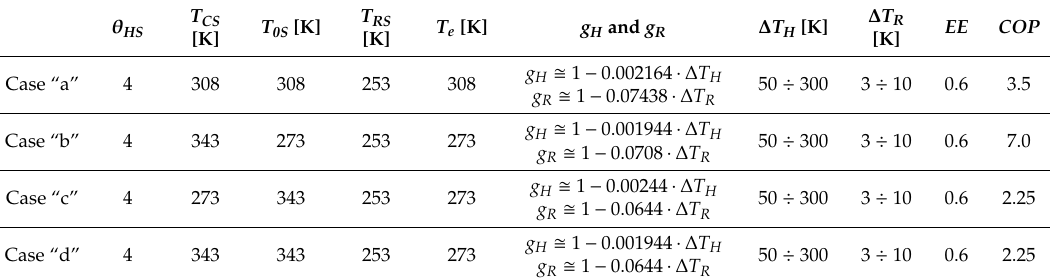
Table 1. The design restrictive conditions of the trigeneration system.